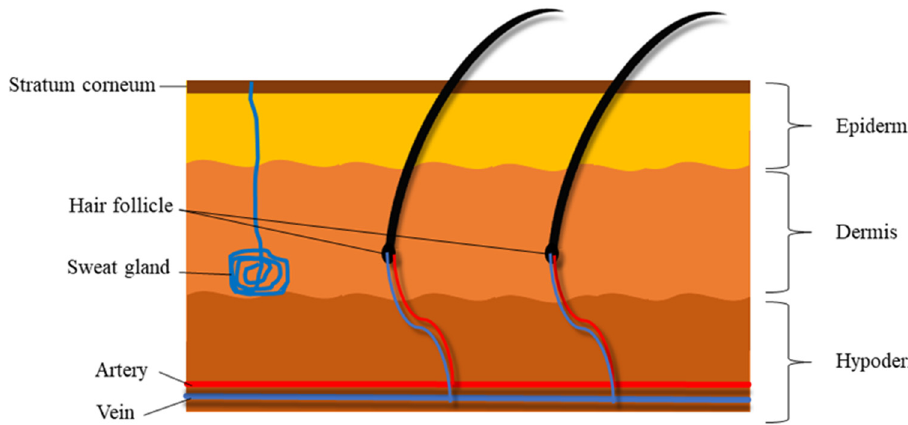
Figure 1. Simplified structure of the skin and its barriers.